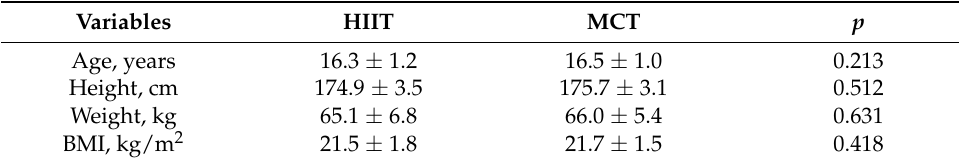
Table 3. General characteristics of